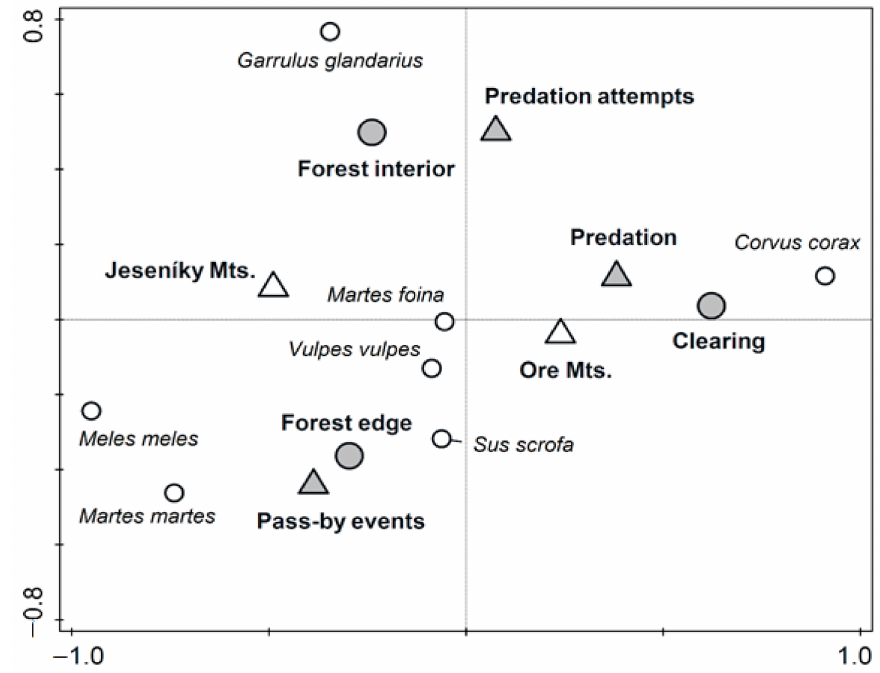
Figure 3. Projection scores for each recorded predator species by artificial nests in Jesen í ky and Ore Mts. with respect to three habitats and predators’ behavior. CCA analysis, I. and II. ordination axes together explain 65.3% of variability.